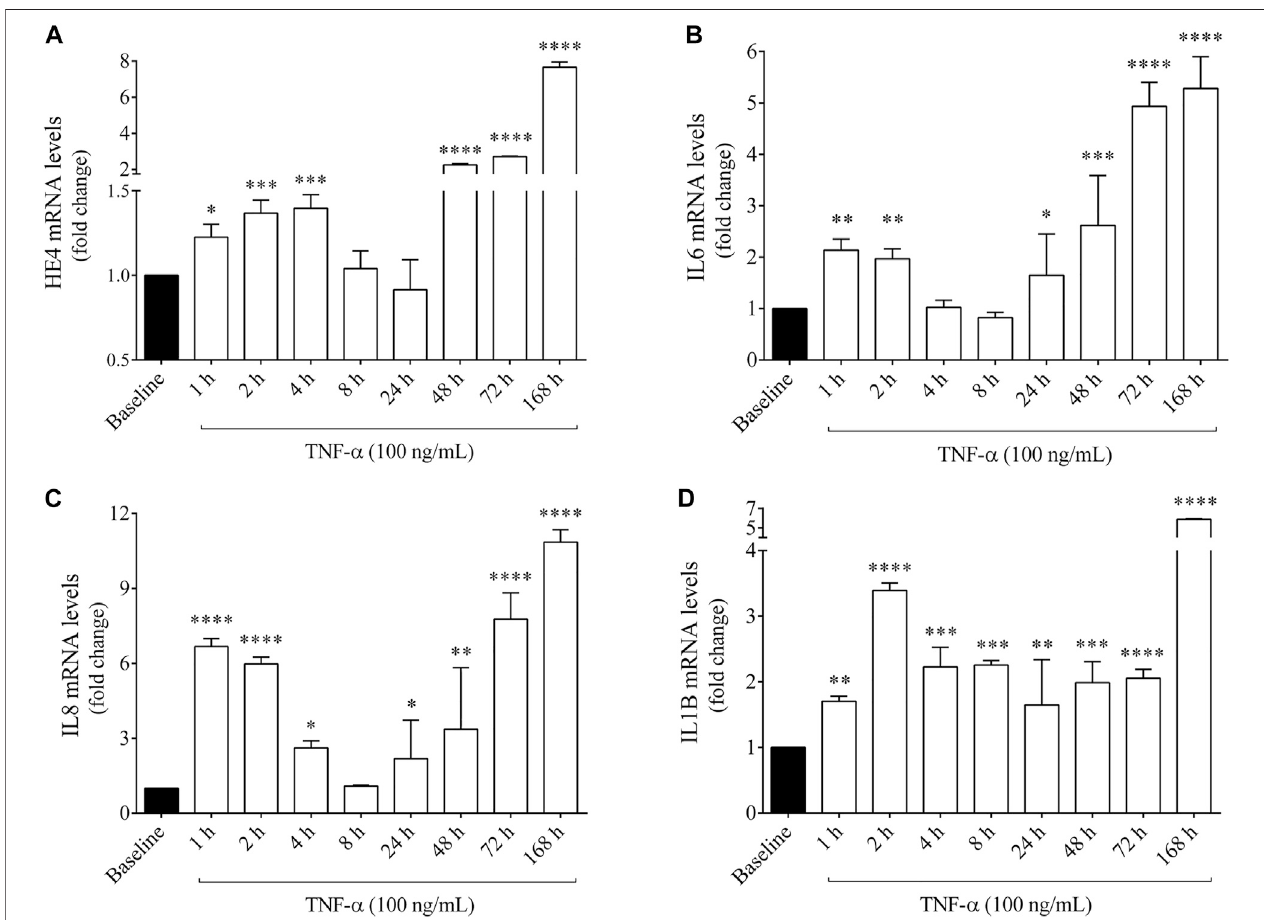
FIGURE3| Quanti fi cationofHE4,IL6,IL8andIL1BmRNAlevelsinF508del-CFTRCFBE41o − cellsafterTNF- α stimulationfor1 hupto1 week invitro .HE4mRNA level was higher than baseline at 1 – 4 h that returned to normal range by 24 h and was further induced by TNF- α (100 ng/ml) after 48 h up to 168 h (A) IL6 mRNA level wasalreadyinducedby1 – 2 handwasfurtheraugmentedafter24 h (B) Inparallel,IL-8expressionshowedasimilartime-coursealterationtoHE4andIL6 (C) ,whileIL1B mRNA level had a sustained elevation without a substantial alteration during this time period (D) Mean ± SEM (n (cid:2) 4 – 5 samples/condition). * p < 0.05, ** p < 0.01, *** p < 0.001, and **** p < 0.0001 vs. baseline, based on ANOVA with Bonferroni ’ s multiple comparison test.